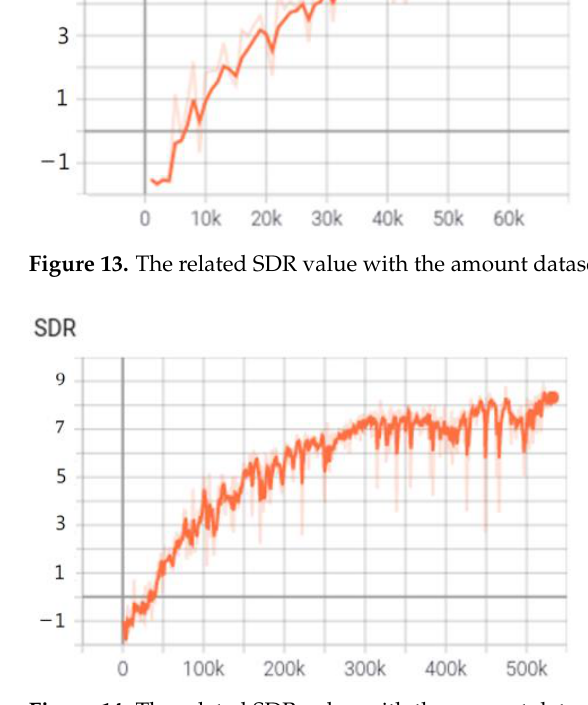
Figure 14. The related SDR value with the amount dataset of 1200 people. (2)